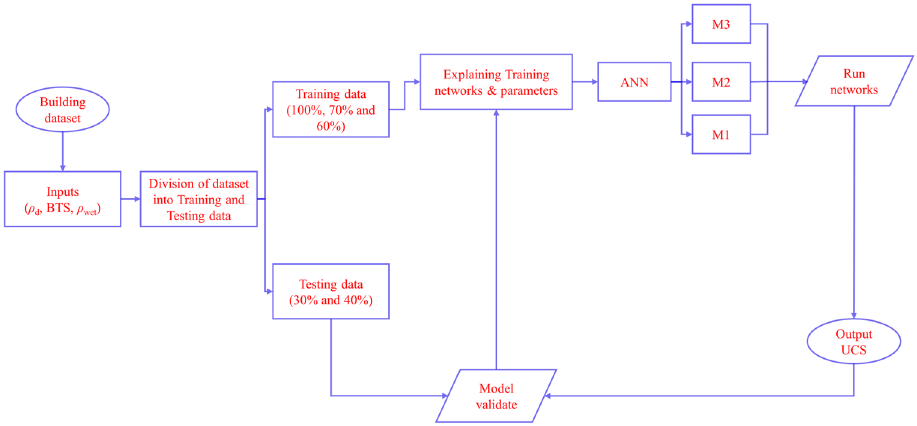
Figure 5. Flow chart of the predictive modeling process for UCS.